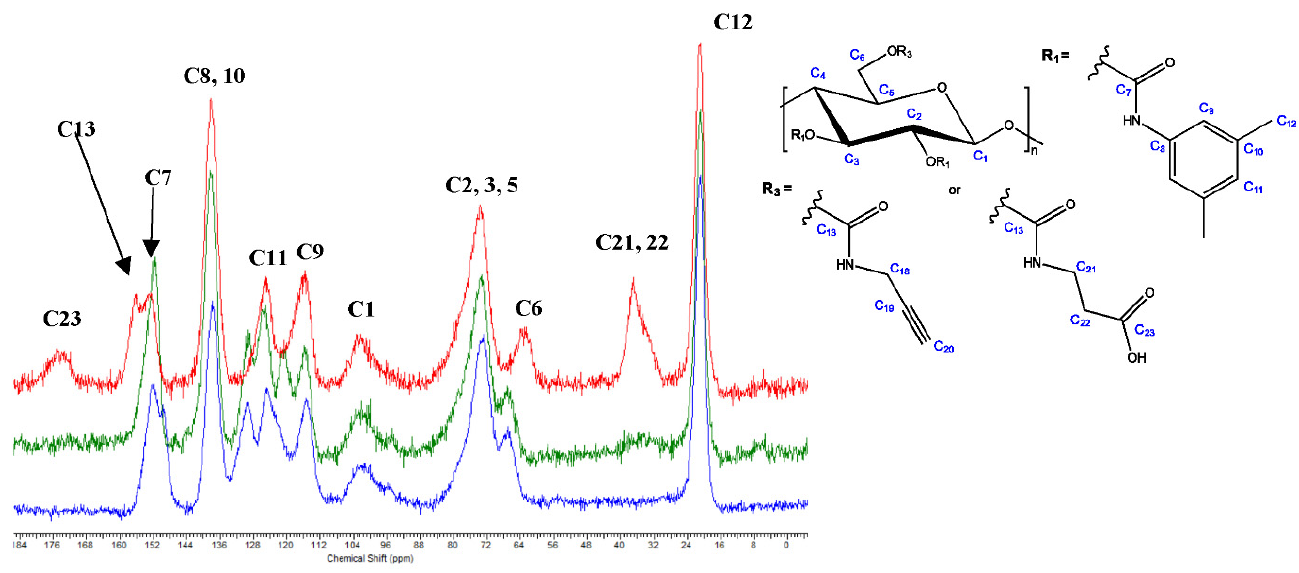
Figure 5. Solid-state 13 C NMR spectra of cellulose derivatives 13aD (red) vs. 11c (green) and 11b (blue).